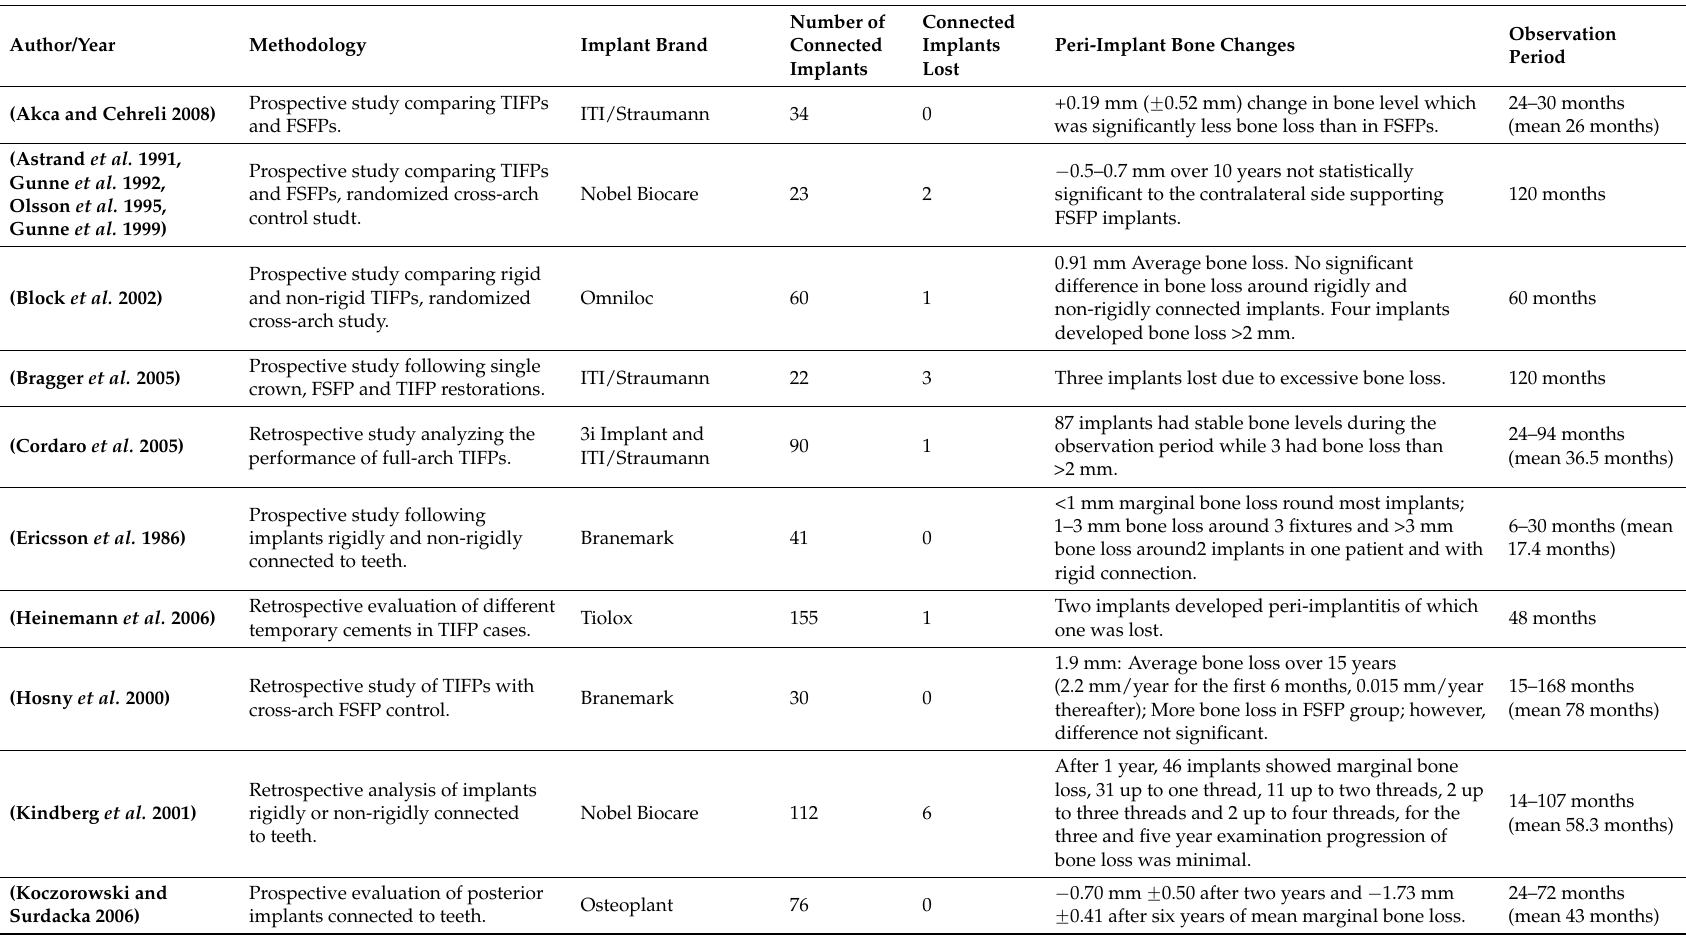
Table 3. Table of studies detailing failures of implants supporting